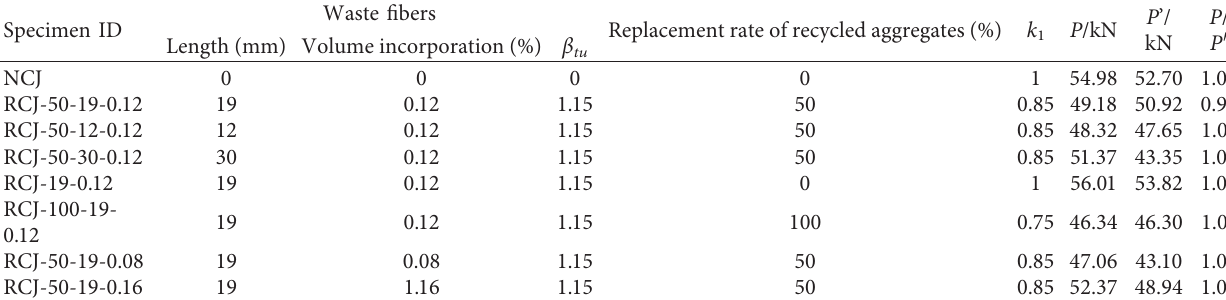
Table 6: Calculation value P and test value P ′ of ultimate bearing capacity of column-beam